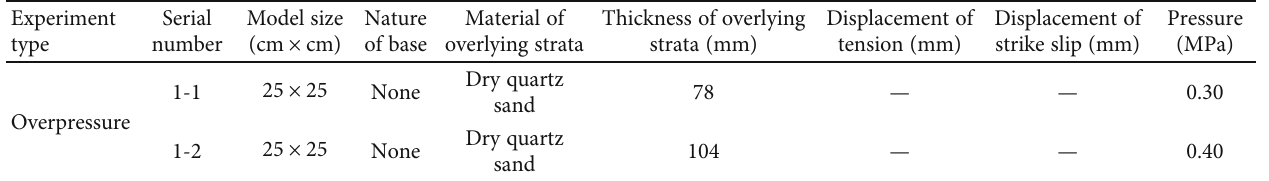
Table 3: Experimental parameters and record results of the overpressured